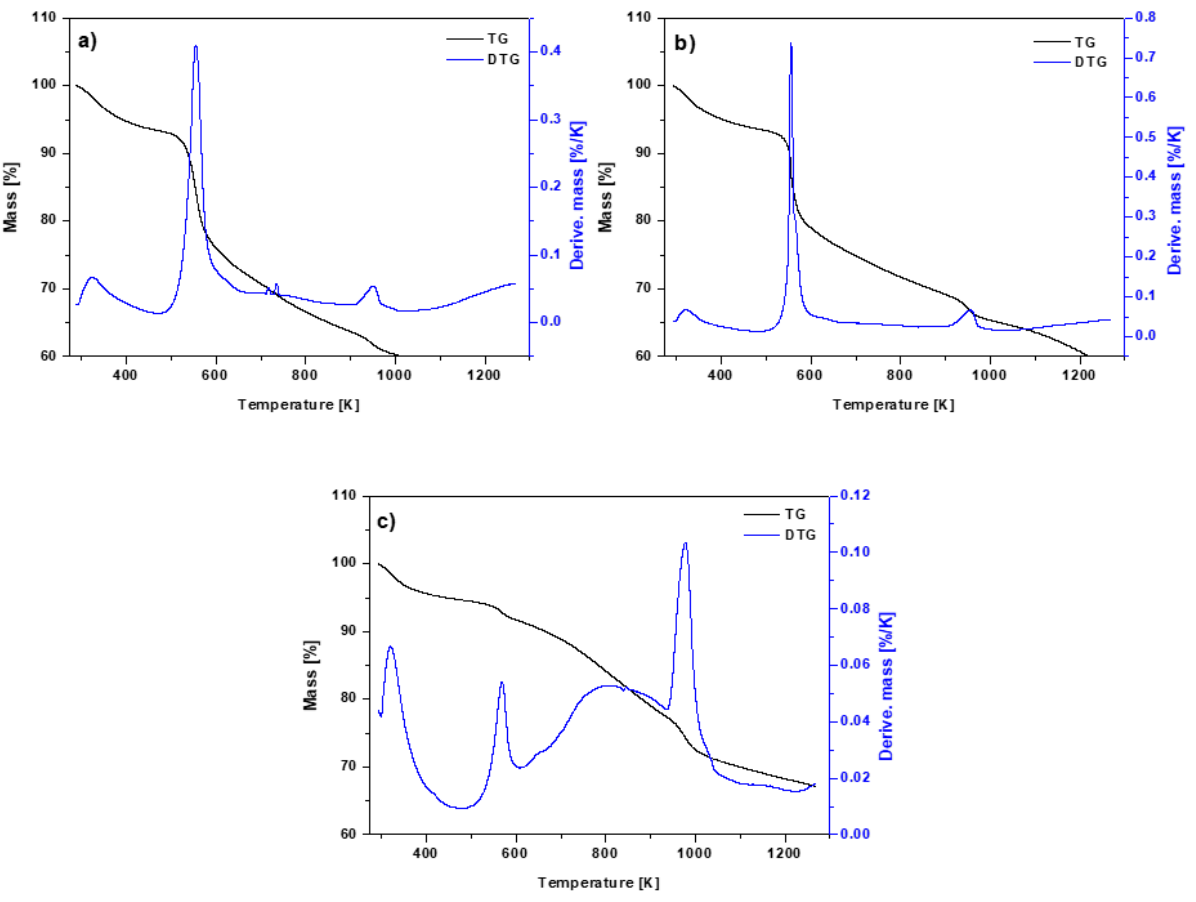
Figure 7. TG and DTG curves of ( a ) BC-CS 1-1, ( b ) BC-CS 2-1 and ( c ) BC-CS 4-1. The breakdown residues of hemicellulose, cellulose and lignin are responsible for the other phases of the biochar heat degradation, dropping to 823 K. The decomposition